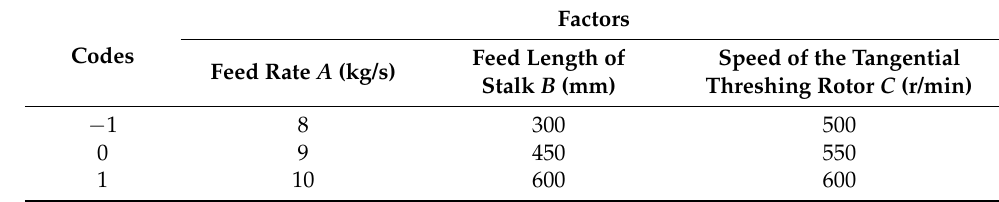
Table 1. Codes of experiment